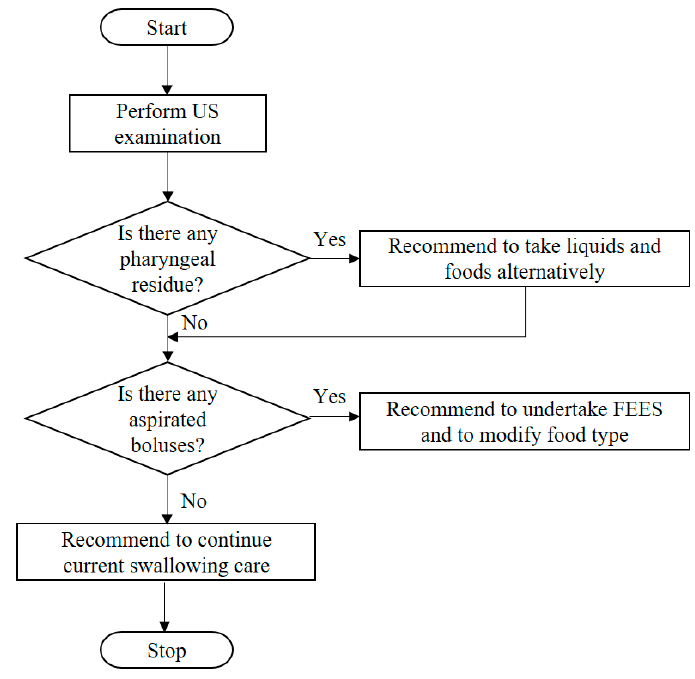
Figure 1. Algorithm of recommendations for swallowing care.